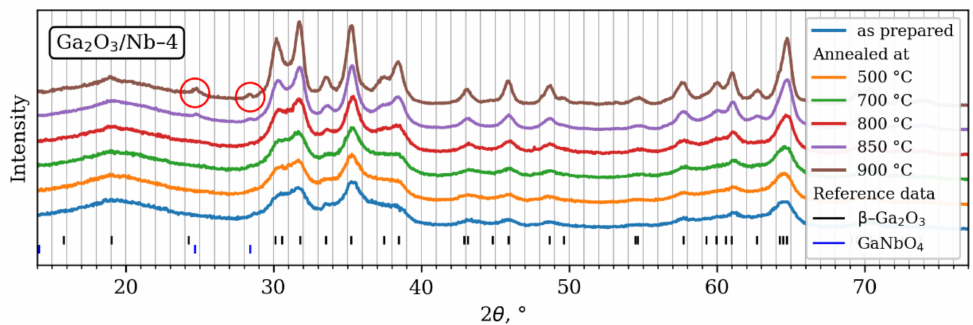
Figure 1. XRD patterns of synthesized materials with highest Nb content and analysis of phase composition.